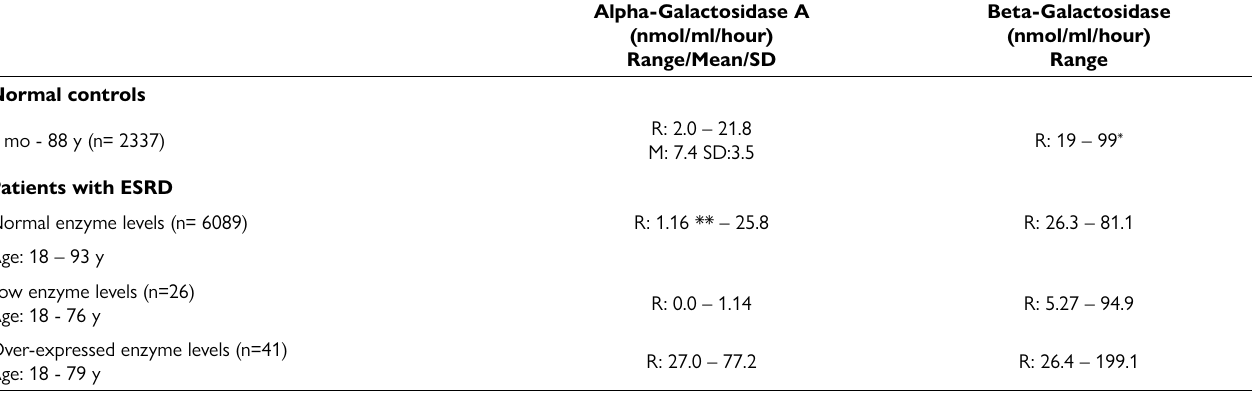
Table 1. DBS enzymatic activity for Alpha-Galactosidase A and Beta-Galactosidase in males.